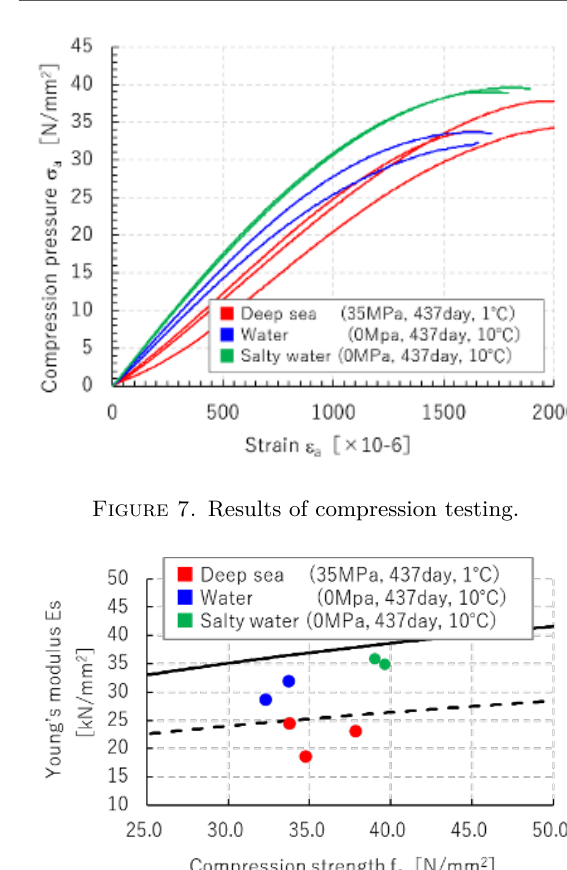
Figure 8. Relationship between compression strength and Young’s modulus.